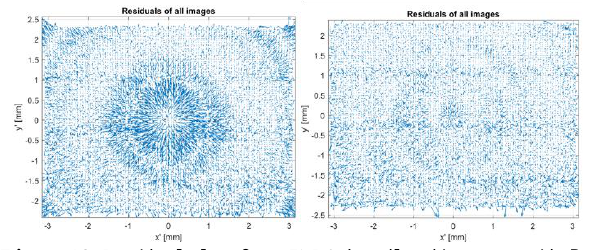
Figure 13. Residual plots from IAPG bundle adjustment with B and B+O for DJI (data set 4); vector scale 100.